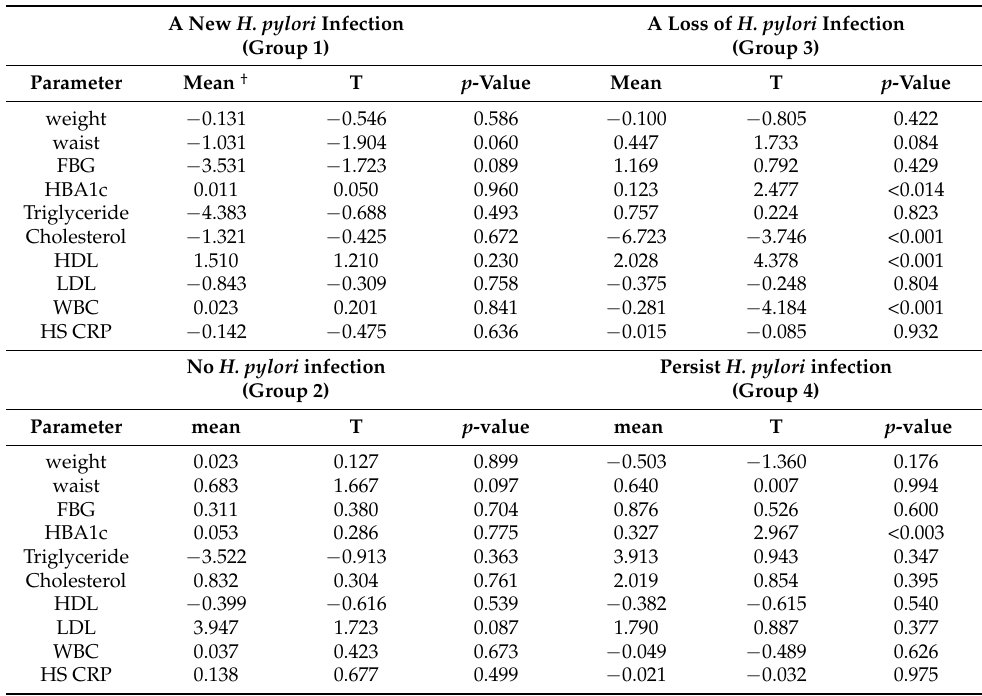
Table 3. Intragroup mean values change after a different infection status of H. pylori